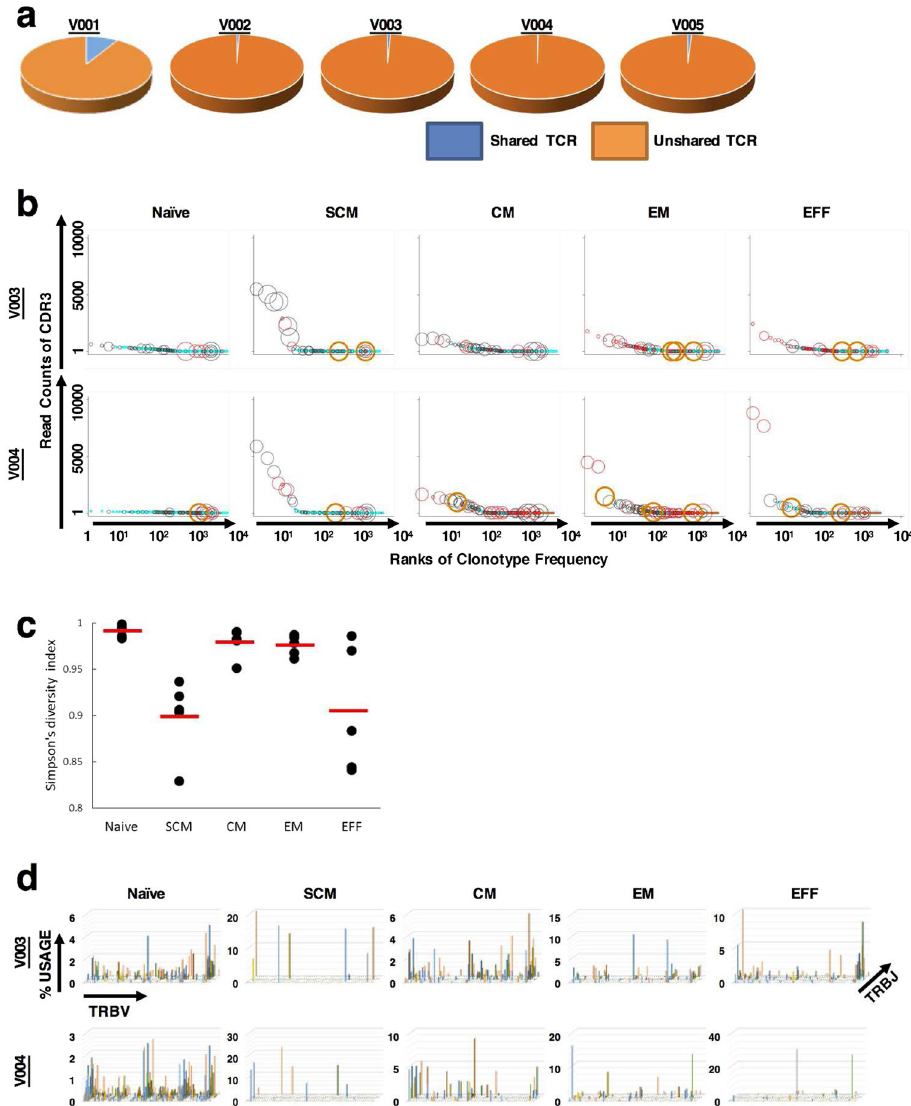
Figure 4. Shared TCRs among five healthy donors present in their populations of T cells and functional CD8 + T cell subsets. ( a ) Ratio of unique reads of shared and unshared TCRs in the entire T-cell populations. The pie charts represent the total number of unique reads of TCRs in the entire T cell populations. Blue and orange indicate the percentage of unique reads of shared and unshared TCRs, respectively. ( b ) Random sampling of 35,000 reads was performed in each T cell subset and each donor. Each circle or dot in the plots shows one unique read of TCR β . TCR β clonotypes are ordered according to their frequencies in descending order on the x-axis. The y-axis depicts the read numbers of the clonotypes. Shared non-CMV NLV-specific TCRs ( ○ ) and unshared non CMV NLV-specific TCRs ( ● ) are shown as black circles and blue dots, respectively. Shared CMV NLV-specific TCRs ( ○ ) and unshared CMV NLV-specific TCRs ( ● ) are shown as red circles and dots, respectively. Orange thick circle ( ○ ) represents one of nine dominant TCRs in V001 (TCR ID; 001-17, 001- 48, 001-41) and V004 (TCR ID; 004-66, 004-22, 004-63, 004-30, 004-28 and 004-71) (Fig. 2a). The sizes of the circles are directory proportional to numbers shared among the five donors. The largest circles indicate the shared clonotypes by the five donors and the dots indicat the unshared clonotypes. Wilcoxon rank-sum test and Kendall’s tau test were performed. The P values of all tests were < 0.05, which indicates a significant correlation between the total reads and the sharing count of the TCRs, even in the naïve subset. The results of this analysis were similar for donors V002, V003 and V005 (Supplementary Fig. 2). ( c ) Simpson’s Diversity Index (SDI) calculated using NGS data for functional T-cell subsets among the five donors. The y-axis depicts SDI, and each dot represents each donor’s SDI of functional T-cell subsets. The horizontal bars show the average SDI among the five donors. ( d ) T cell repertoire plots of functional CD8 + T-cell subsets are the same as shown in Fig. 4c, revealing the lower diversity of the SCM T-cell subset compared with CM and EM T-cell subsets. The results of this analysis were similar for donors V002, V003 and V005 (Supplementary Fig.